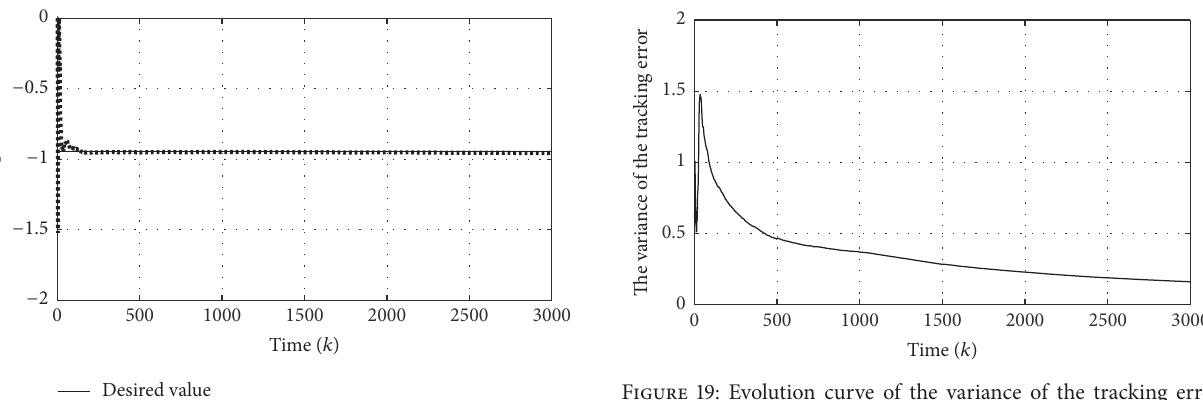
Figure 19: Evolution curve of the variance of the tracking error 𝜎 2 (𝑘) . 𝜐